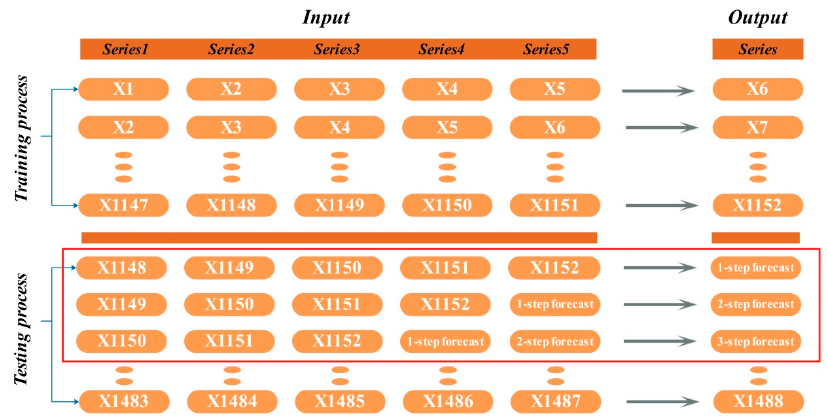
Figure 2. Data selection scheme for multi-step forecasting. In the red box are the data selection methods of 1-step, 2-step and 3-step forecasting, respectively.